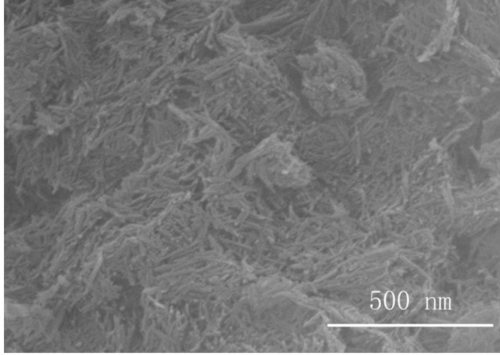
Figure 1. SEM images of nanowires.